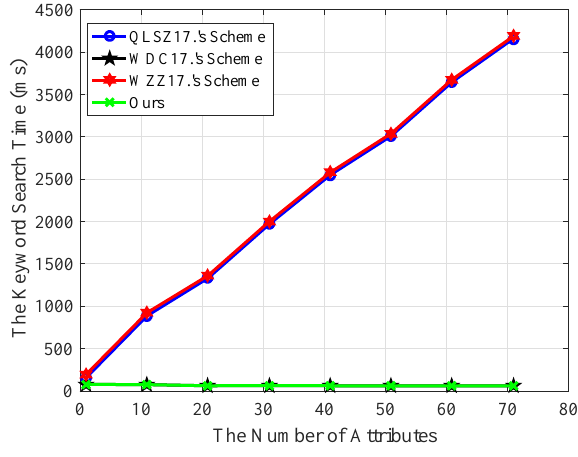
Figure 7. The comparison of keyword search